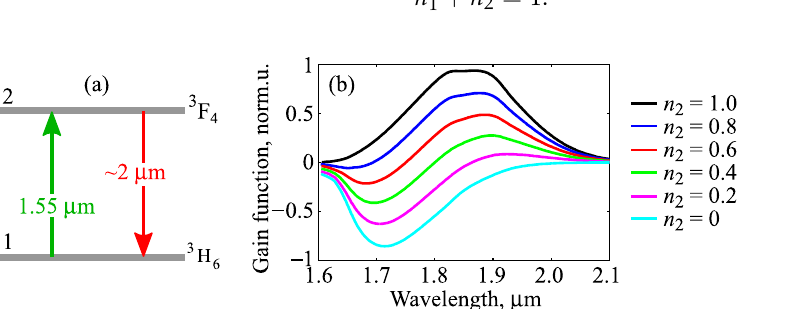
Figure 2. ( a ) A simplified scheme of laser levels for in-band pump. ( b ) Normalized gain function proportional to ( σ em n 2 − σ abs n 1 ).